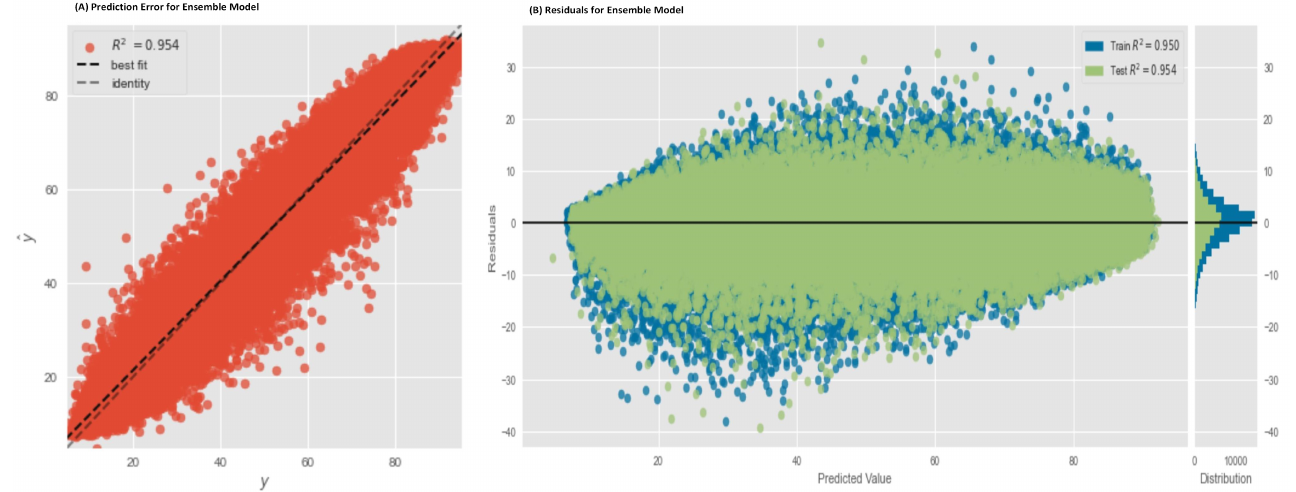
Figure 16. Accuracy of Ensemble Model for Relative Humidity